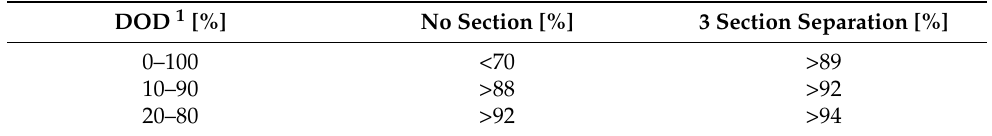
Table 2. The accuracy rate with calculated